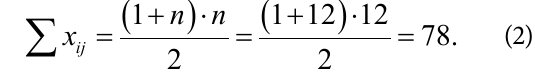
Table 1. Overall matrix of ranks